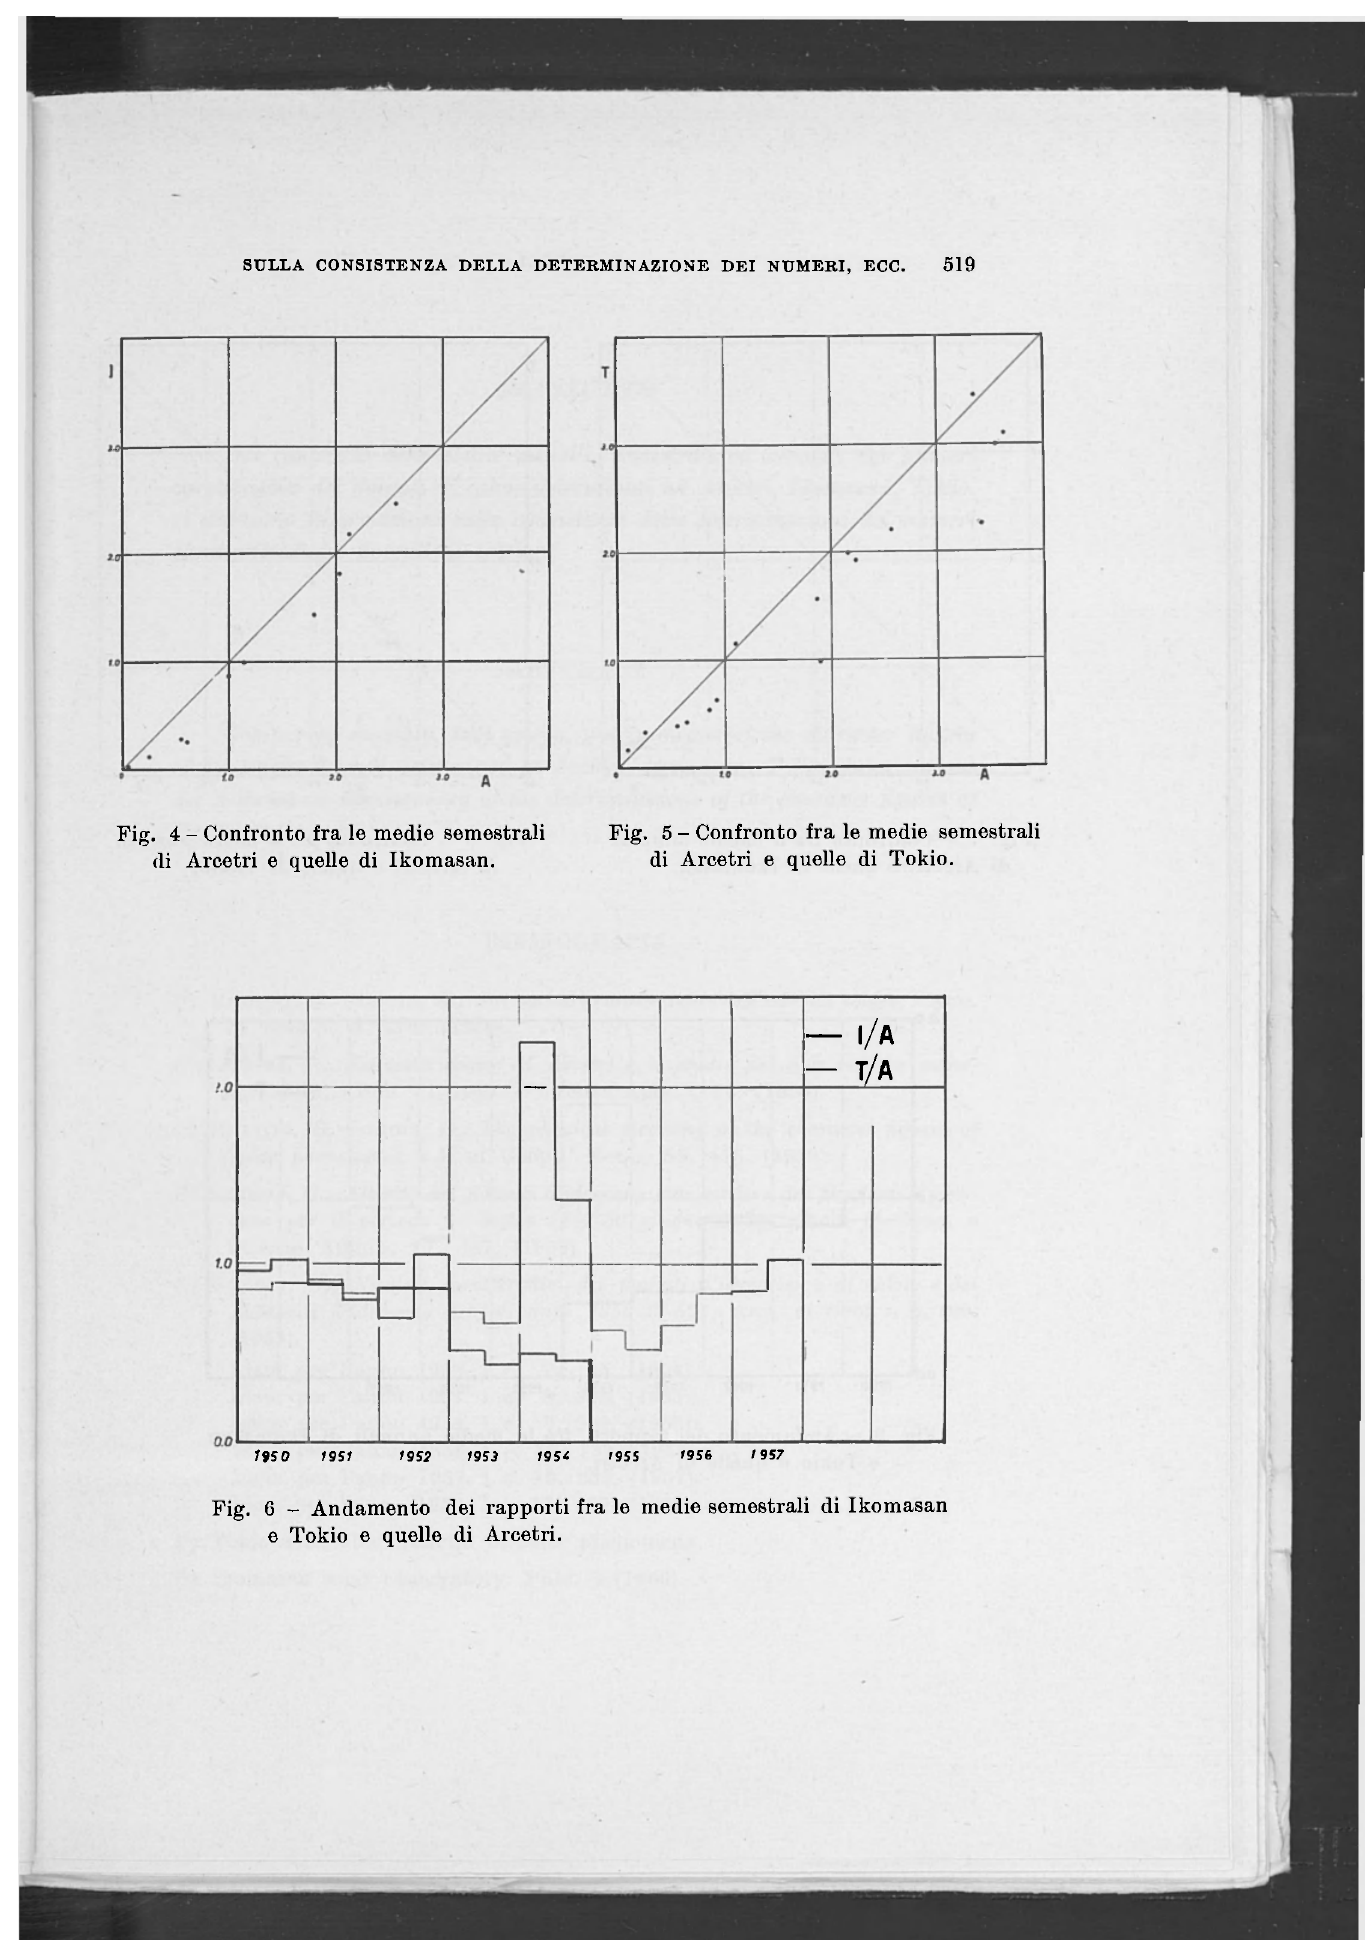
Fig. 6 - Andamento dei rapporti fra le medie semestrali di Ikomasan e Tokio e quelle di